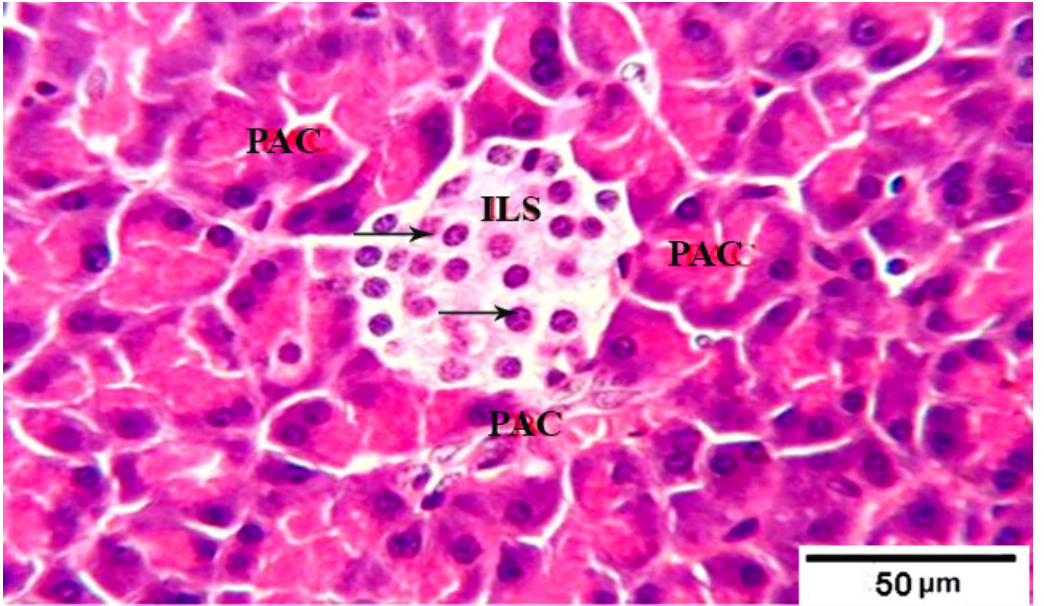
Figure 2. Photomicrograph of pancreatic tissue sections from group 2 rats showing: pale distorted Figure 1. Photomicrograph of pancreatic tissue sections from control group 1 rats showing: well islets of Langerhans (ILs) in between the acidophilic pancreatic acini (arrowheads), separated by edema (stars). The acinar cells had vacuolar degeneration and dissociation (arrowheads) and the defined normal large pale islets of Langerhans (ILs) with normal cellular shape and density (arrows) islets showing depletion of its constituent cells (arrows). H&E stain. The bar size is indicated under in between the acidophilic pancreatic acini (PAC). H&E stain. The bar size is indicated under picture.